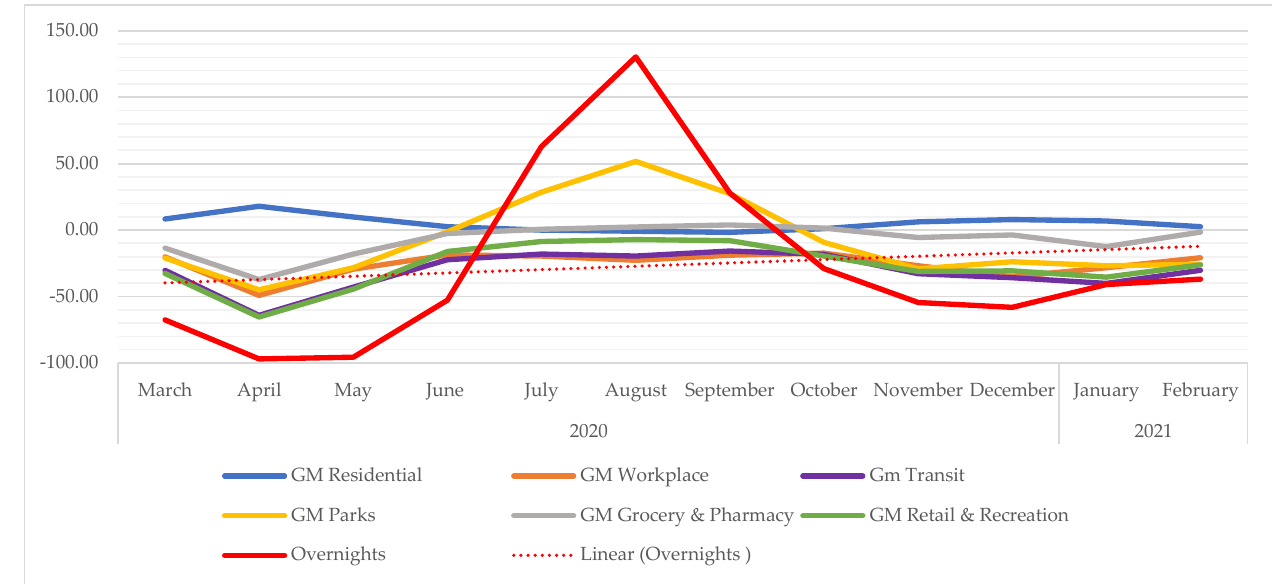
Figure 2. Time series for variables.